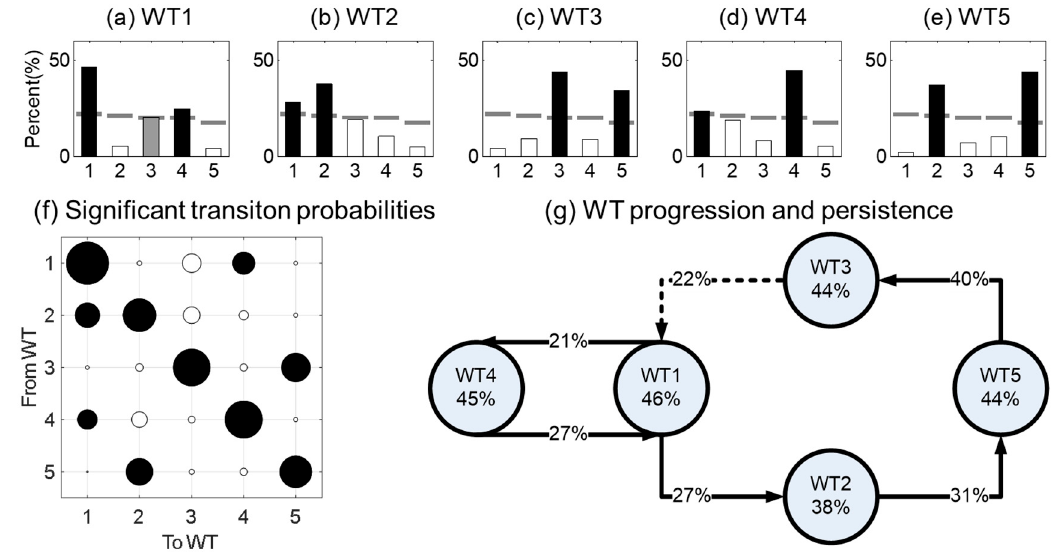
Figure 5. Progression of each WT, shown as frequency of WTs both on days following ( a ) WT1, ( b ) WT2, ( c ) WT3, ( d ) WT4, and ( e ) WT5 days. The distribution on the next day and the previous day is shown in the first and second rows, respectively. Significant and not significant conversions are shown with black bars and white bars, respectively. ( f ) Significant probability transitions from one WT to another one. ( g ) Graphical representation of WT progression and persistence. Significant and not significant conversions are represented by solid arrows and dotted arrows, respectively.